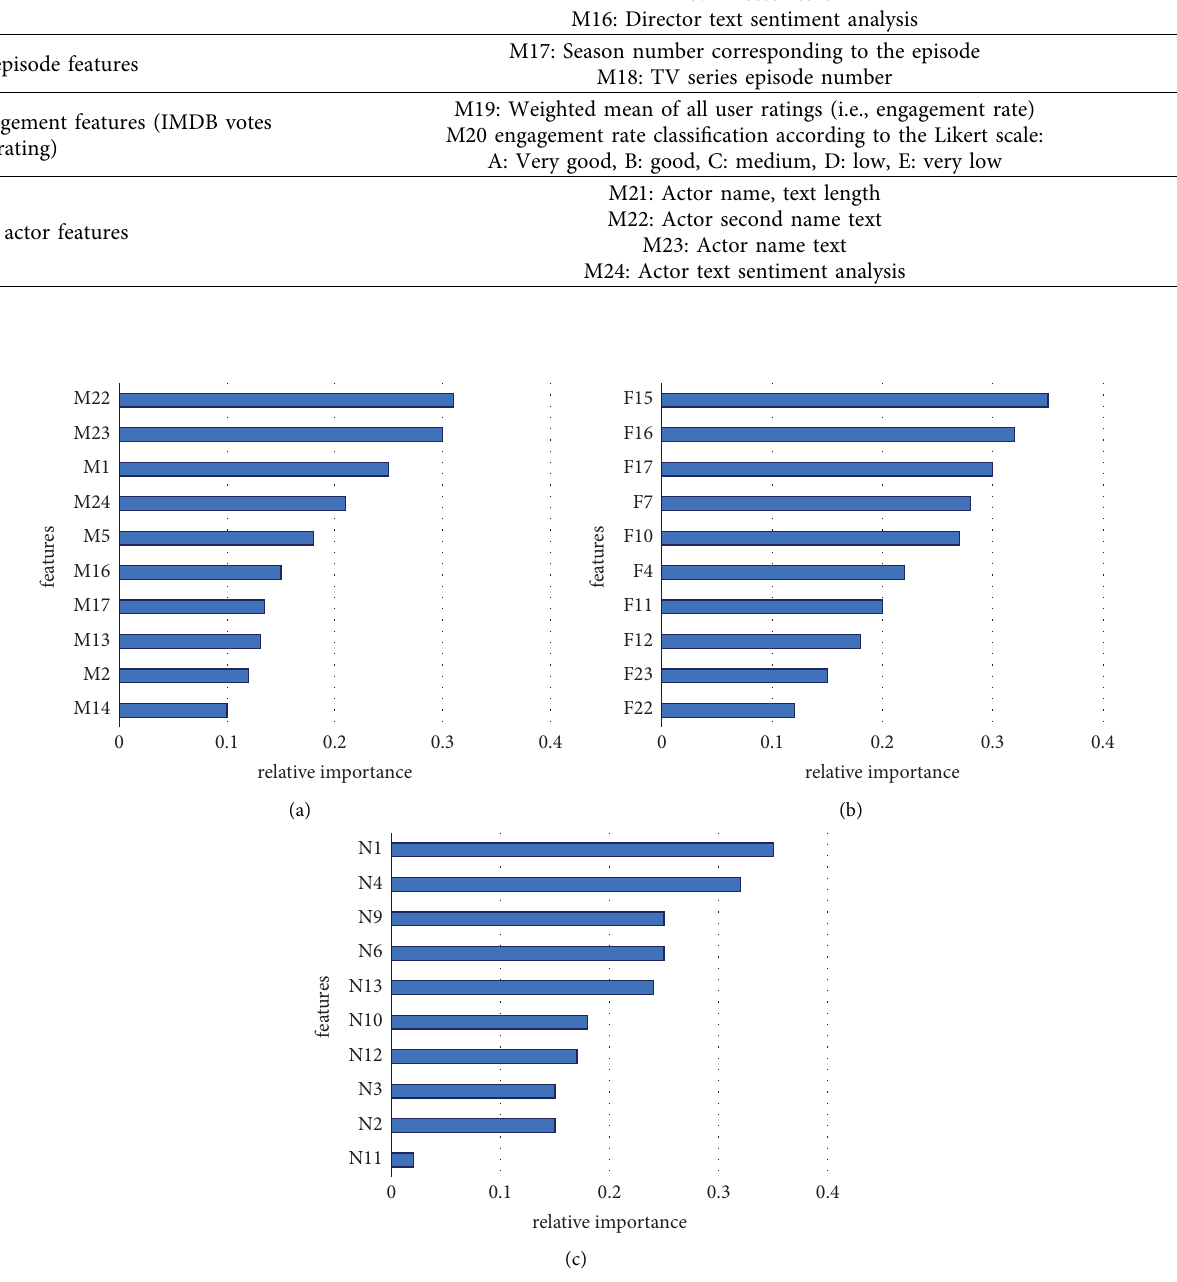
Figure 5: The factor significance of the 10 top features using the XGBoost method. (a) IMDB dataset. (b) Instagram dataset. (c) Taobao